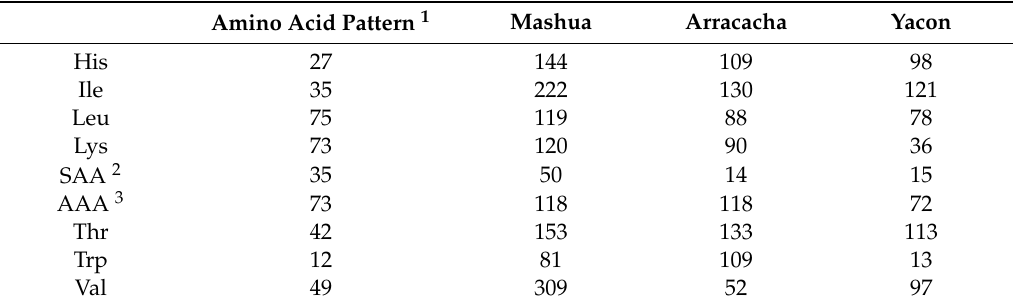
Table 9. Quality assessment for mashua, arracacha, and yacon proteins based on their essential amino acid scoring